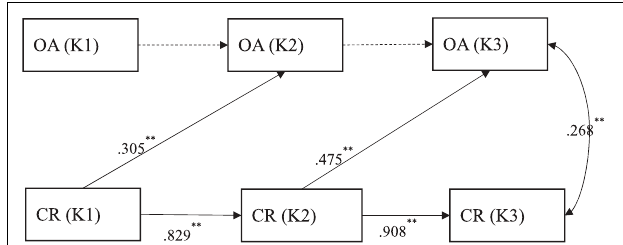
FIGURE 1 | The relationship between orthographic awareness and character reading from K1 to K3. Standardized coefficients are reported. Dashed lines represent non-significant autoregressive paths of OA at different time points. Non-significant cross-lagged and correlation paths were not shown for the simplicity of presentation. OA = orthographic awareness, CR = character reading. ∗ p < 0.05, ∗∗ p < 0.01.